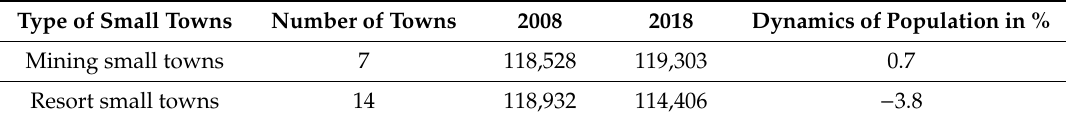
Table 4. Dynamics of population in small mining and resort towns in Poland, 2008–2018. Own elaboration. Type of Small